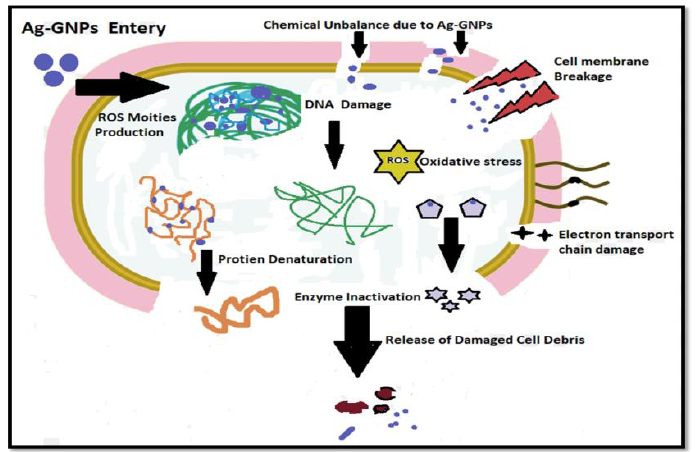
Figure 10. Proposed mechanism of bacterial cell death induced by Ag-GNPs nanocomposites.